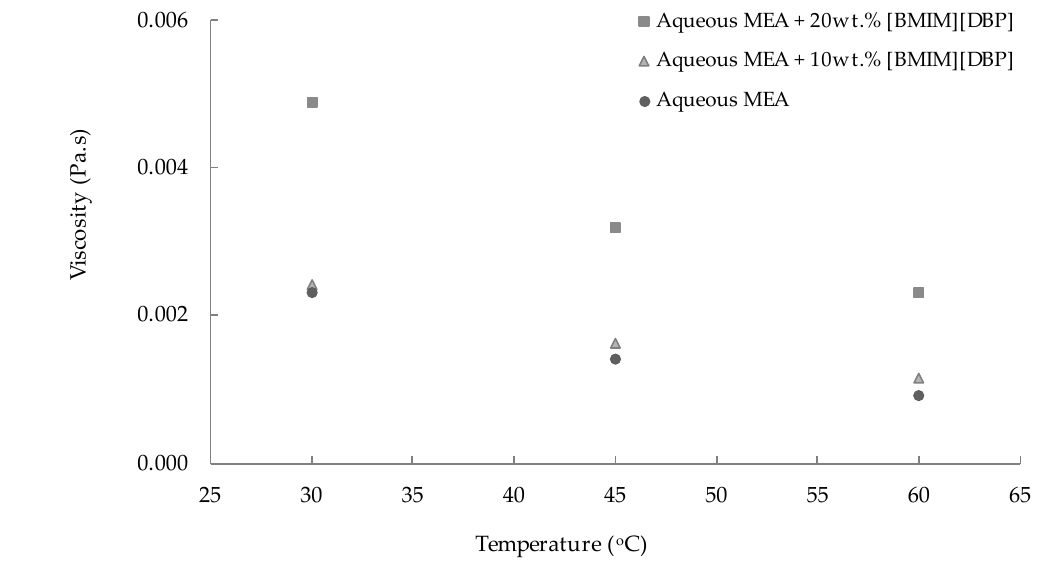
Table 2. Fitting parameters of Equation (5) to correlate density ( ρ ) of aqueous 30 wt% MEA- (BMIM)(DBP).